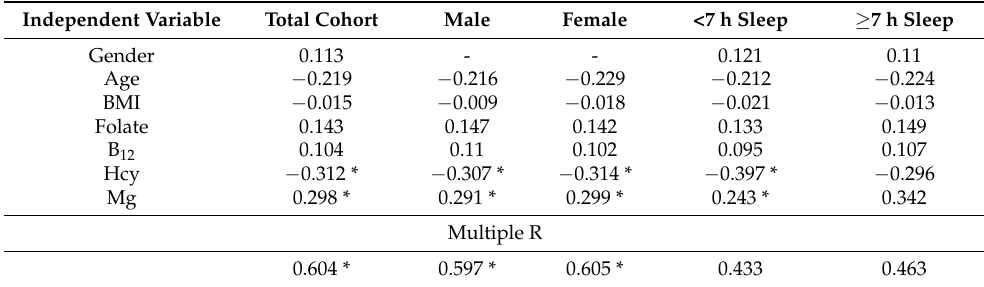
Table 2. Multiple regression analysis in the total cohort and sub-groups for the association of TL in peripheral blood lymphocytes with various independent